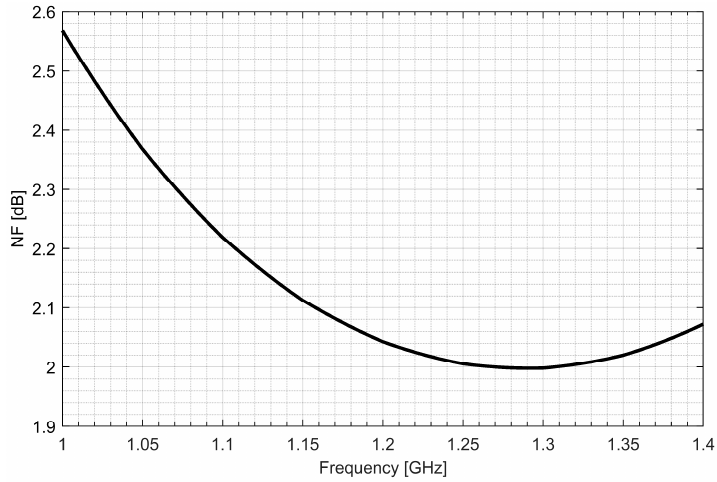
Figure 7. Noise figure characteristics of the L5/E5 low-noise amplifier.